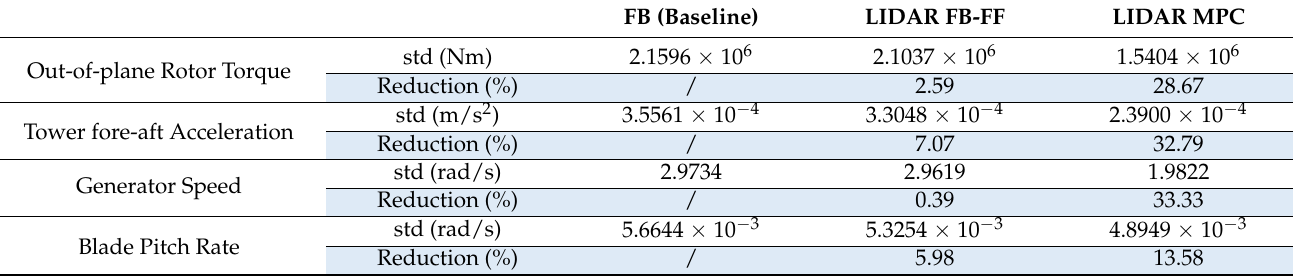
Figure 15. Blade pitch rate: ( a ) time profiles; ( b ) cumulative PSD (wind speed with 15% turbulence intensity). Table 5. Performance statistics for a wind speed with 15% turbulence intensity. FB (Baseline)